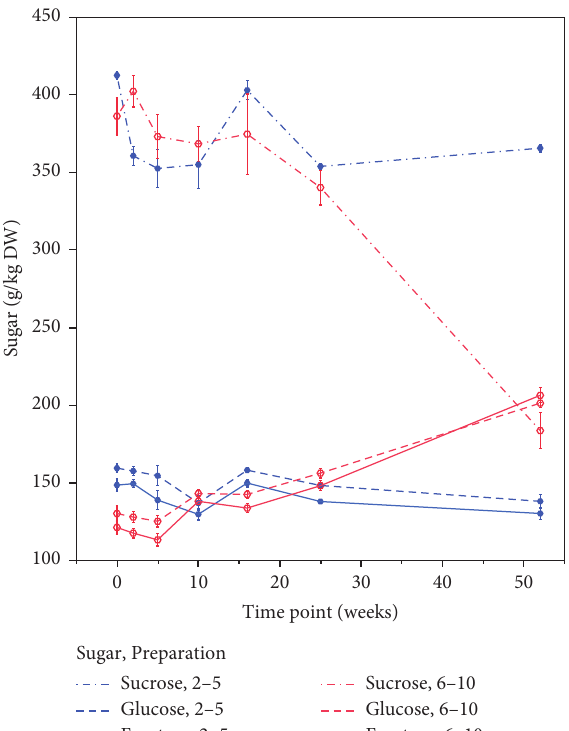
Figure 5: Mean levels of 3 sugars in the persimmon chips over the 1-year course of the storage study. Each error bar is constructed using 1 standard error from the mean. DW � dry weight.